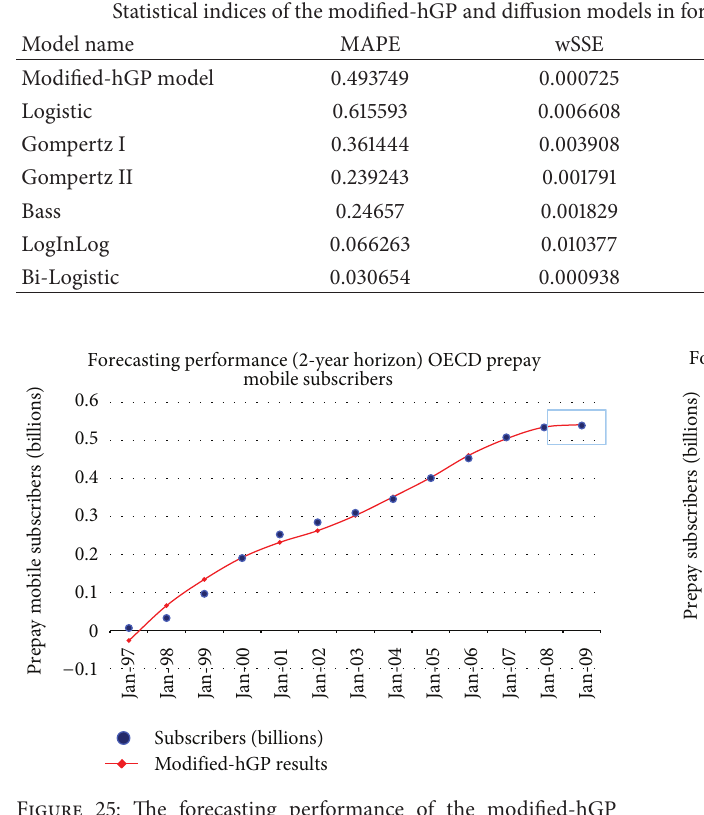
Figure 26: The forecasting performance of the diffusion